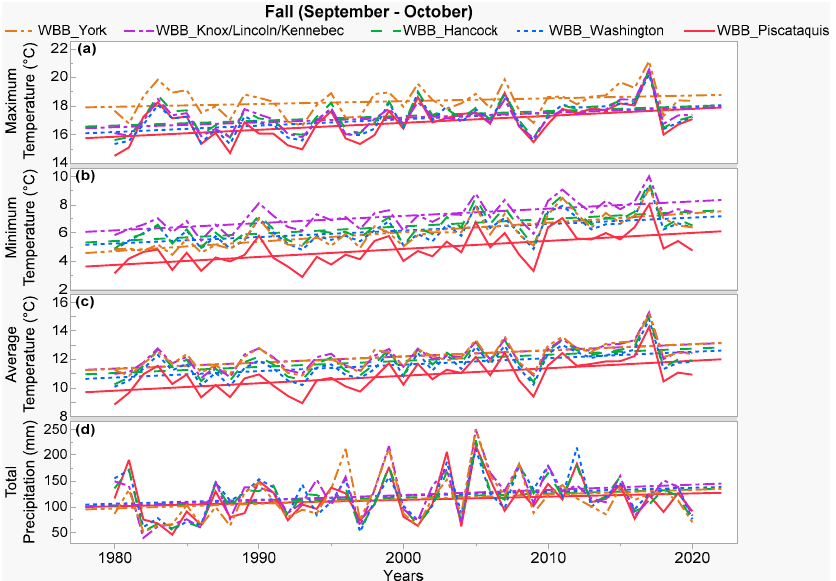
Figure 10. Historical (1980 to 2020) changes with fitted linear regression trendlines for the fall climate parameters: ( a ) maximum temperature, ( b ) minimum temperature, ( c ) average temperature, and ( d ) total precipitation, throughout the studied wild blueberry barrens (WBBs) in different counties from north-central (Piscataquis) and north-east (Washington, Hancock) to south-west (Knox, Lincoln, Kennebec, York) of Maine as shown in Figure 1.